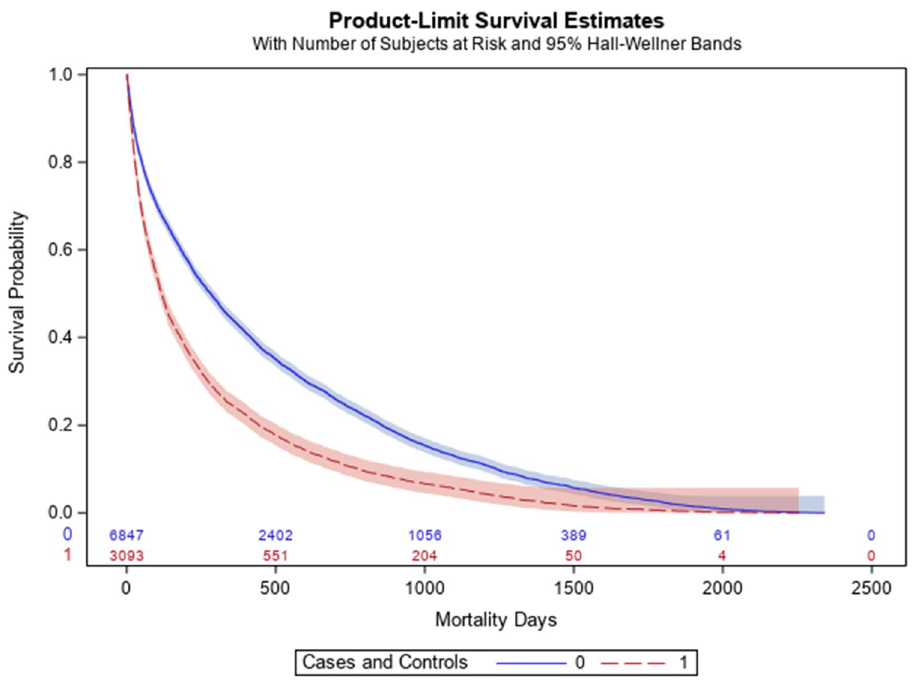
Figure 2. Survival curve for cases vs. controls. Kaplan Meier survival curve comparing days lived from cases (blue line) to controls (red